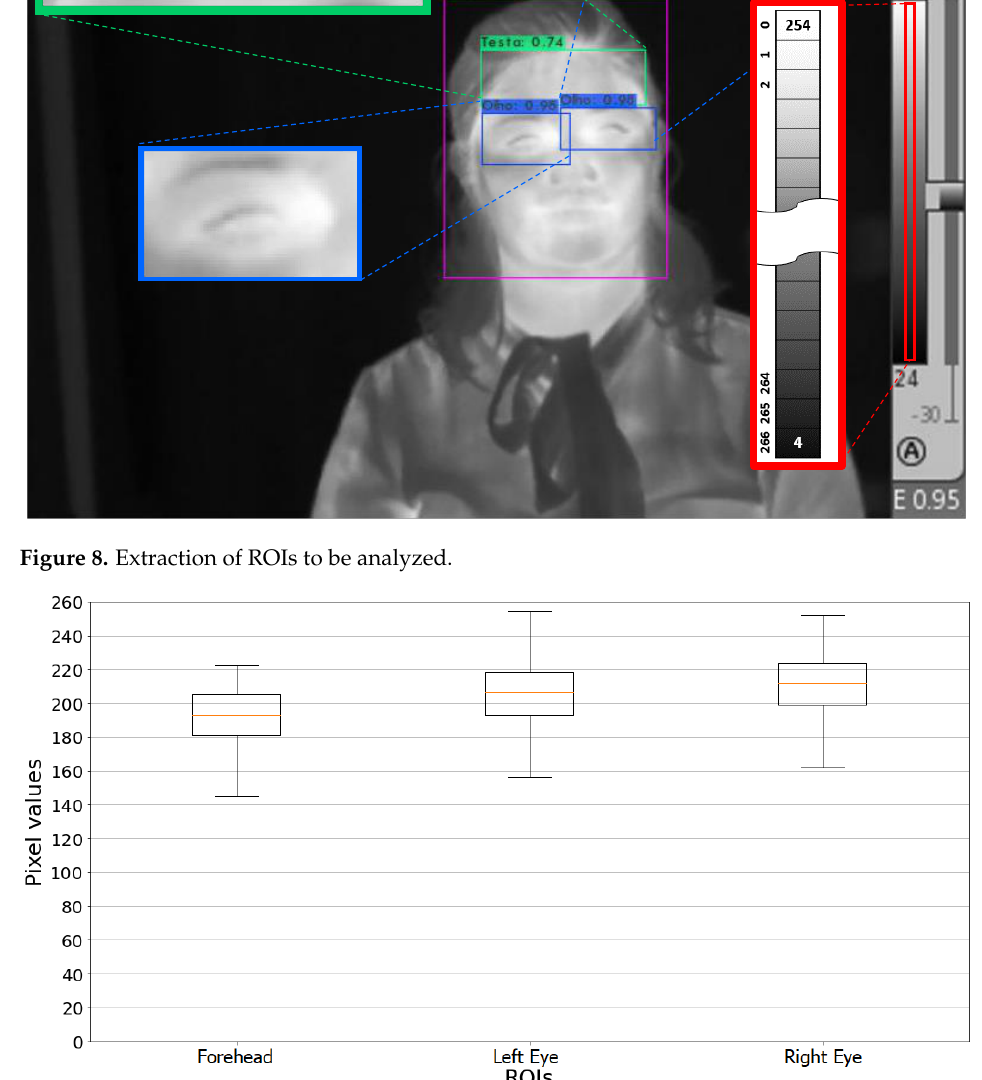
Figure 9. Distribution of pixel values of the ROIs depicted in Figure 8.